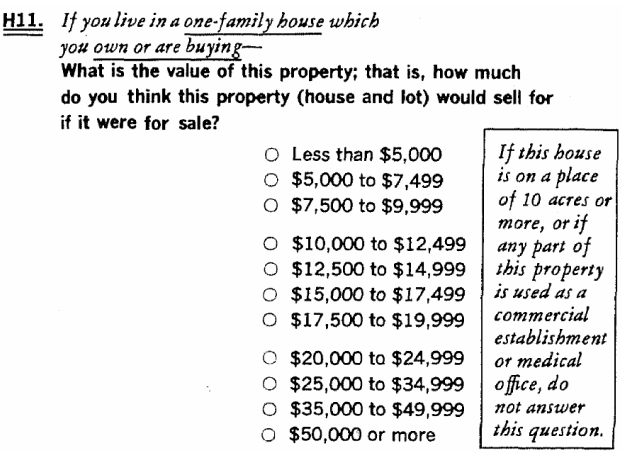
Figure A.1: Scanned copy of 1970 Census question H11.